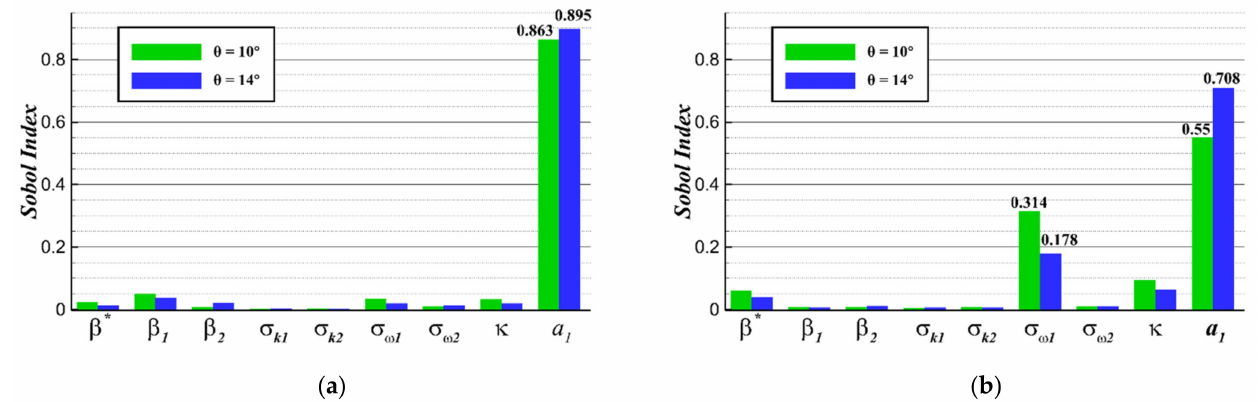
Figure 13. Sobol indices of model’s parameters for the separation and reattachment positions in two cases. ( a ) Position of the separation point; ( b ) position of the reattachment